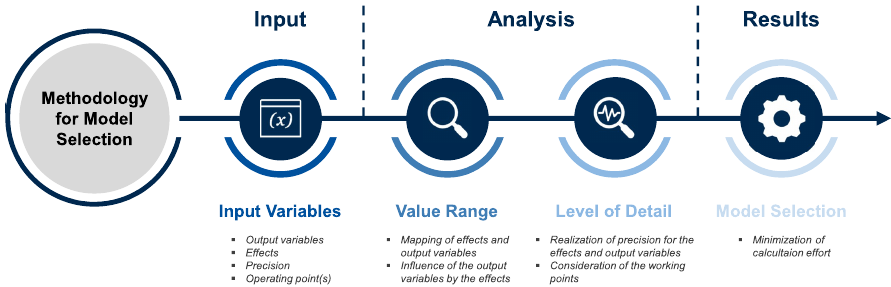
Figure 7. Process of the approach for the model